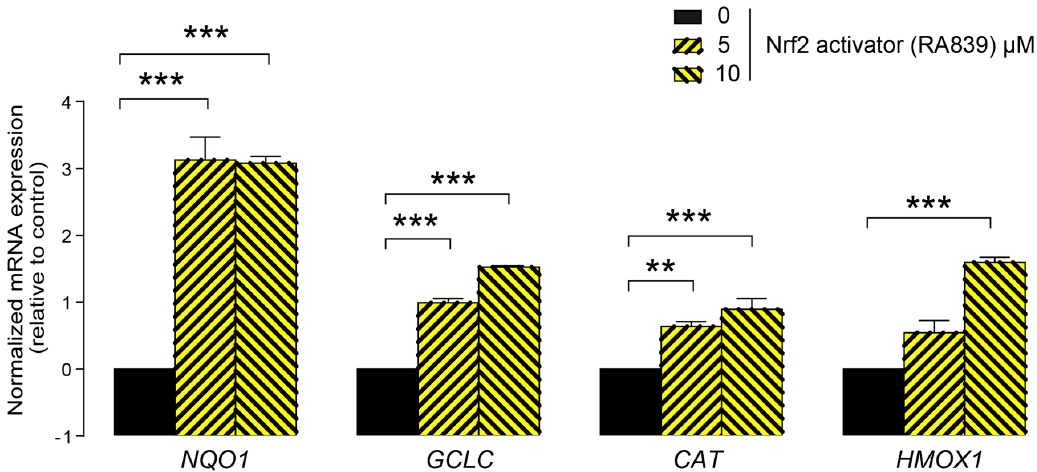
Figure 3. Pharmacological activation of NRF2 induced the expression of NRF2 target genes. The 4T1 cells were treated with the NRF2 activator, RA839, in the concentrations indicated for 48 h, then the expressions of NRF2 target genes, NQO1 , GCLC , CAT , and HMOX1, were determined using RT-qPCR ( n = 3). Abbreviations: NAD(P)H quinone dehydrogenase 1 ( NQO1 ), glutamate–cysteine ligase catalytic subunit ( GCLC ), catalase ( CAT ), and heme oxygenase 1 ( HMOX1 ). Data are plotted as mean ± SD. ** and *** indicate statistically significant differences between control and RA839-treated groups at p < 0.01 or p < 0.001, respectively. Cancers 2019 , 11 , x